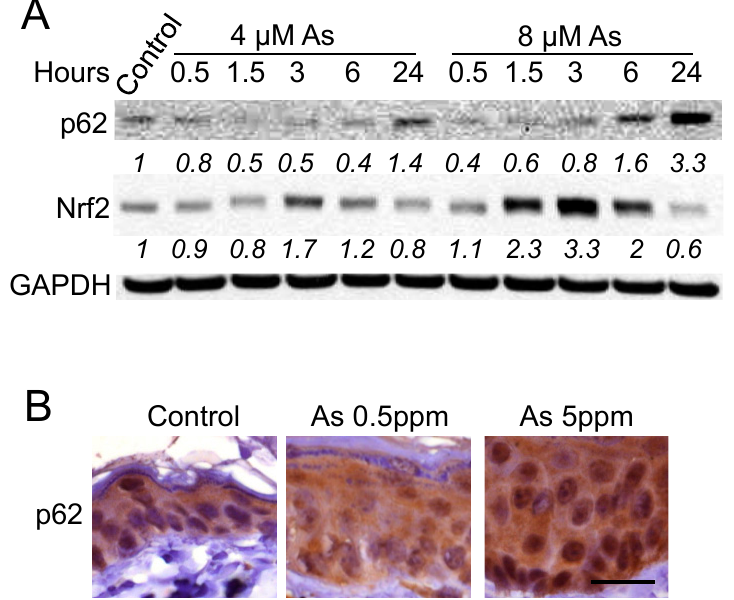
Figure 1. Arsenic induces p62 up-regulation in vitro and in vivo: ( A ) immunoblot analysis of p62, Nrf2 and GAPDH in HaCaT cells treated with vehicle control or arsenic (4 or 8 μ M) over a time course; and ( B ) immunohistochemical analysis of p62 in the skin of nude mice treated with vehicle or arsenic (0.5 or 5 ppm) via drinking water for six months. Scale bar, 20 μ m.